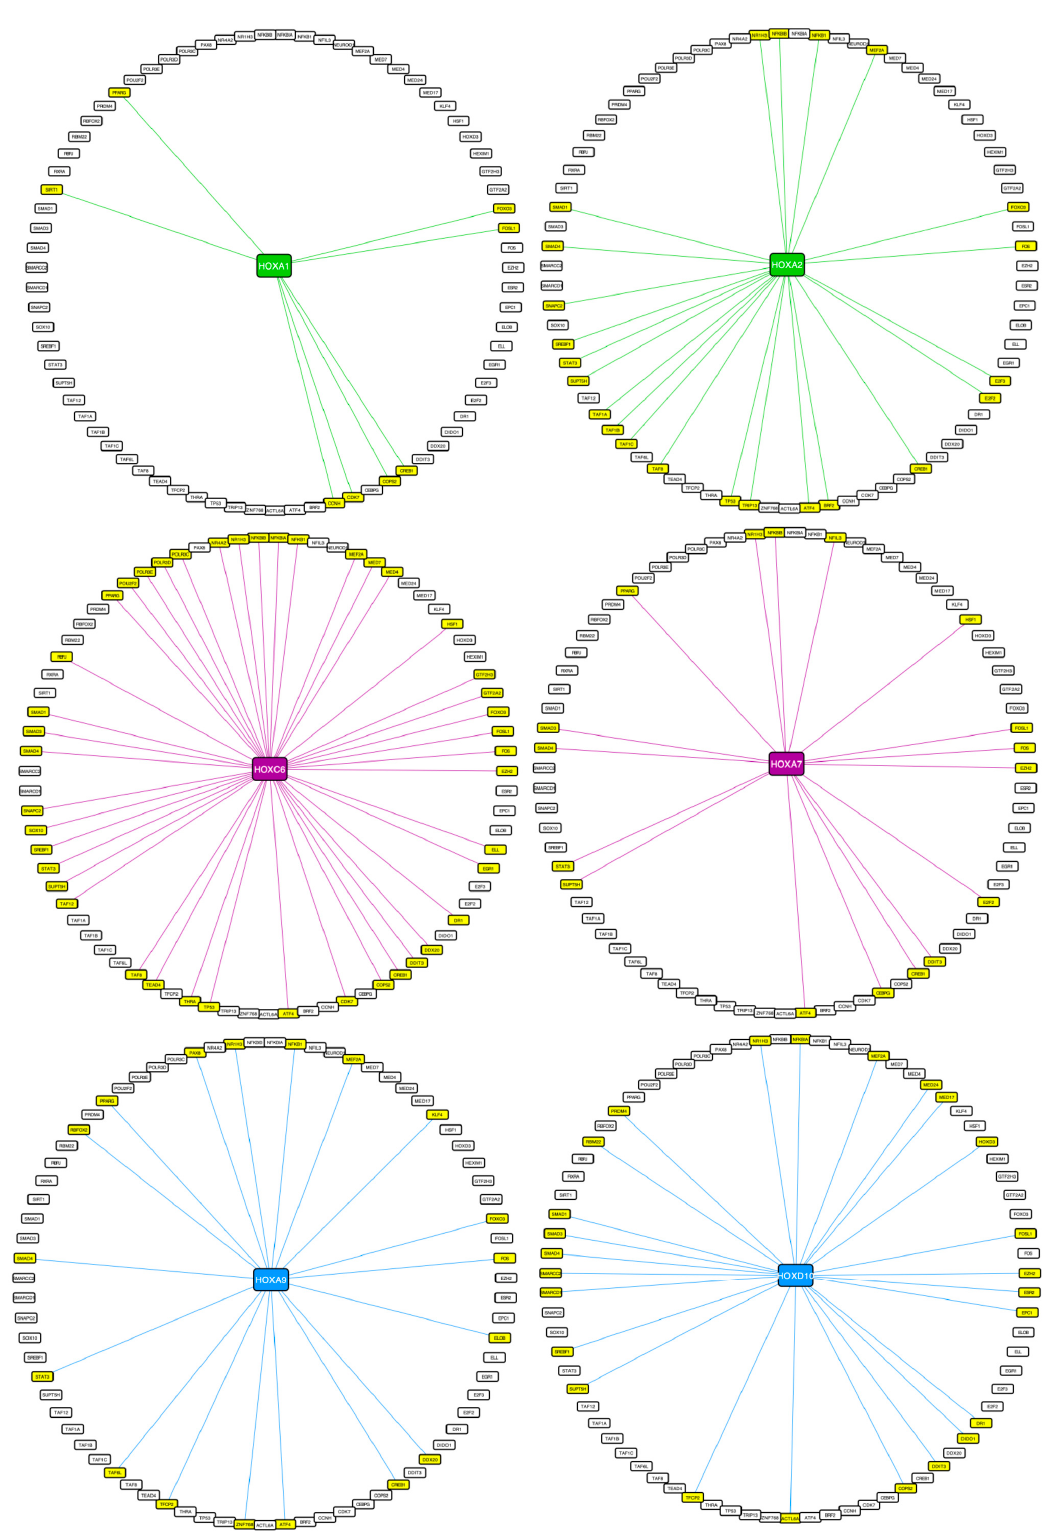
Figure 5. HOX transcriptional interactomes involved in RNA-Pol-II dependent transcription function that was found to be enriched in HOX BiFC screens. Interacting TFs are highlighted in yellow and connected with a trait of the HOX proteins in each representative anterior (HOXA1 and HOXA2 (green)), central (HOXC6 and HOXA7 (violet)) and posterior (HOXA9 and HOXD10 (blue)) HOX